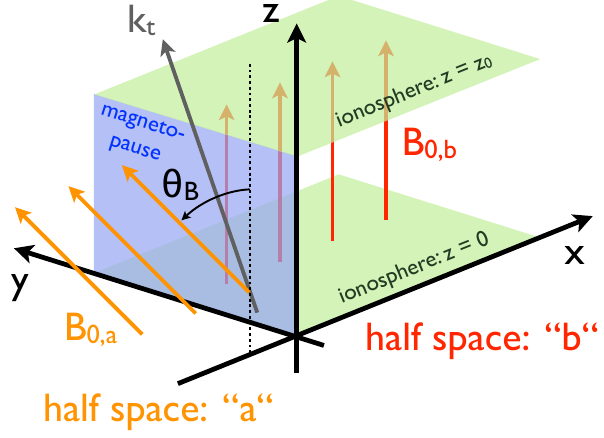
Fig. 1. Sketch of the box magnetosphere: Half space “b” (back- ground) corresponds to the inner magnetosphere. Here the back- ground magnetic field points in z-direction and is confined between the ionospheric boundaries (green surfaces) at z = 0 (south) and z = z 0 (north). In the magnetosheath (half space “a”, foreground) the background magnetic field may be tilted within the y-z-plane. The magnetopause is located between the half spaces at x = 0 (blue